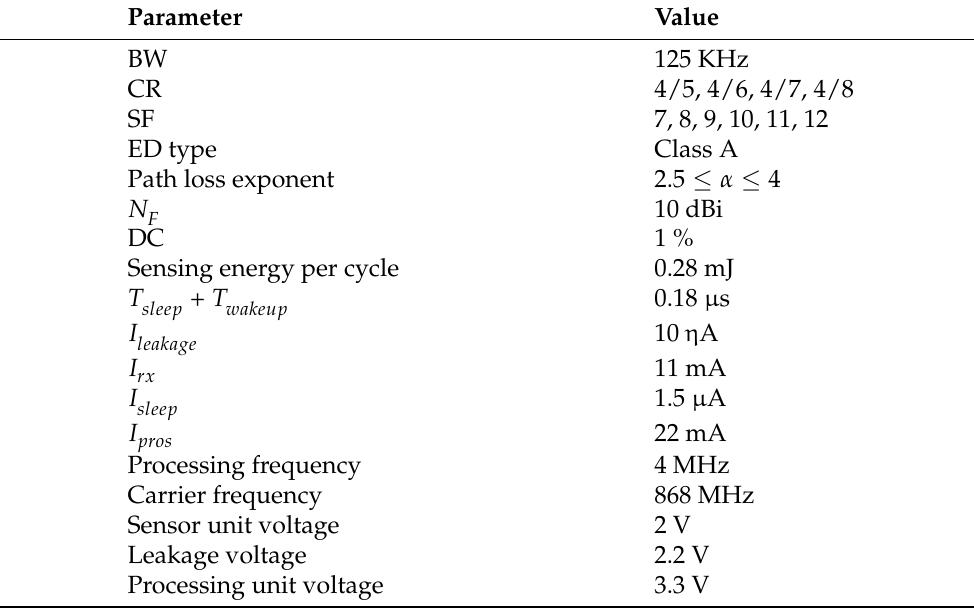
Table 1. Simulation parameter